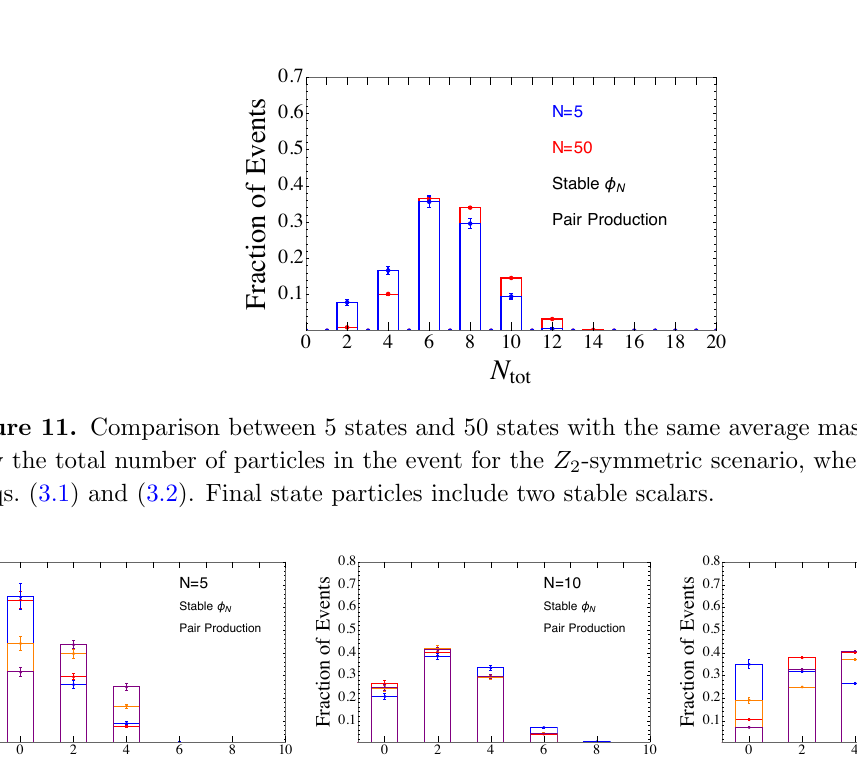
-symmetric scenario, where a SM = a = 0 2